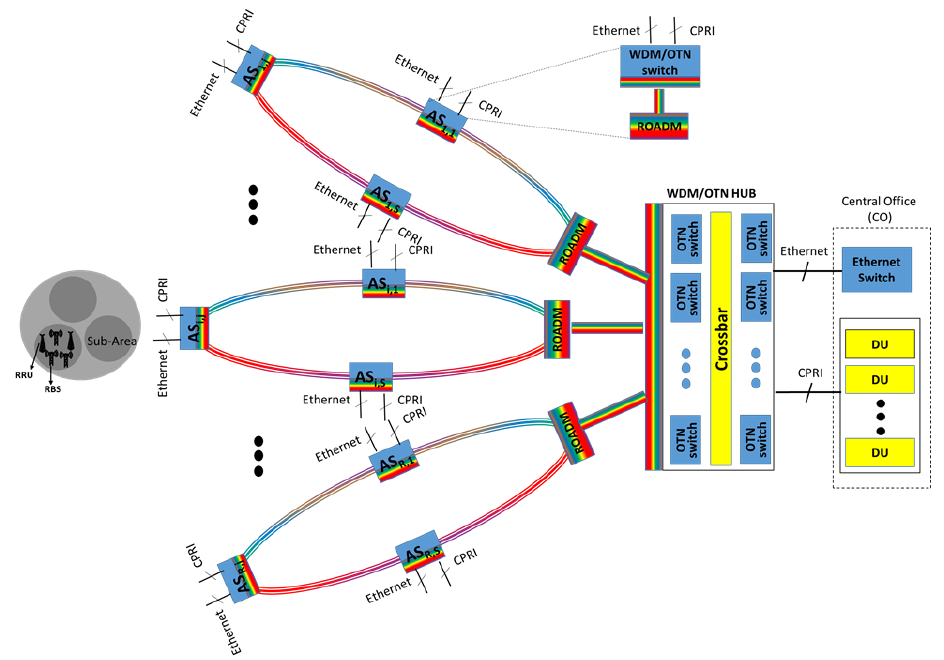
Figure 3. Reference scenario. RRUs and RBSs are connected to ethernet switches and a DU poll through a WDM/OTN transport